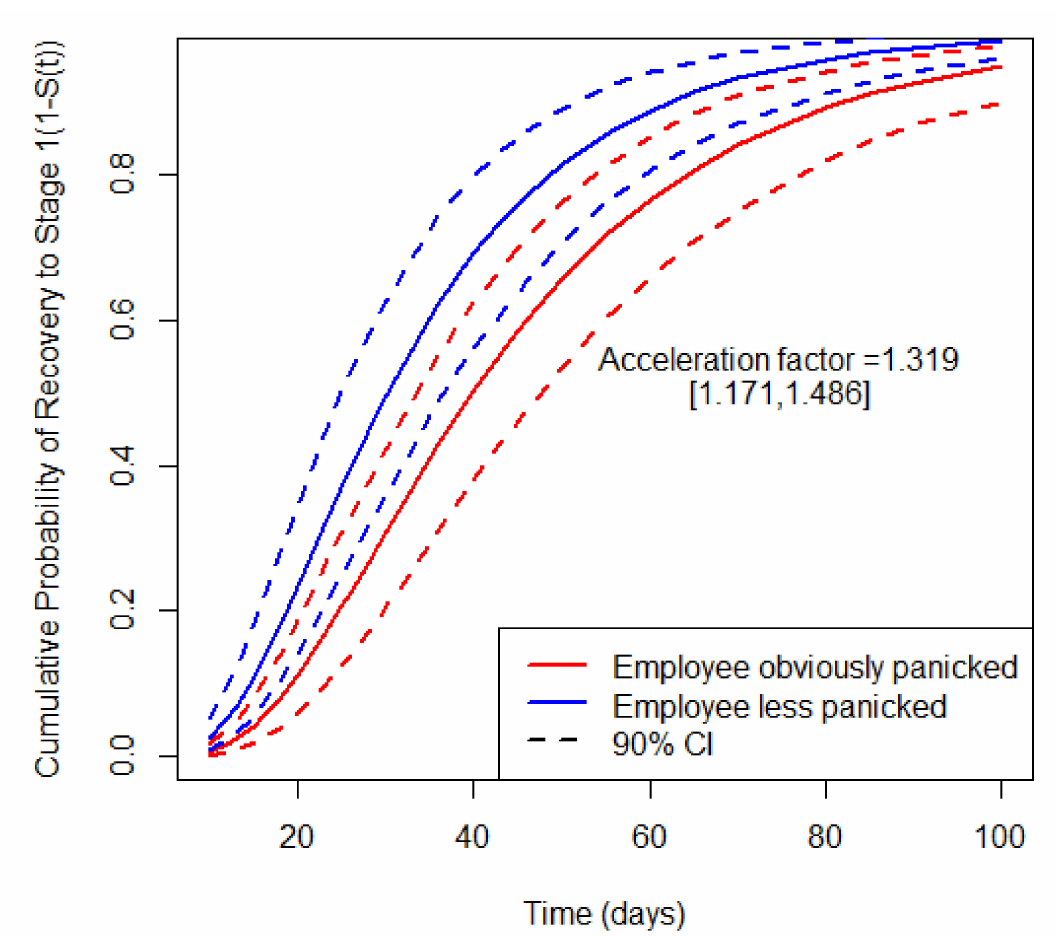
Figure 4. The employees’ panic effect on the recovery probability curves of non-manufacturing